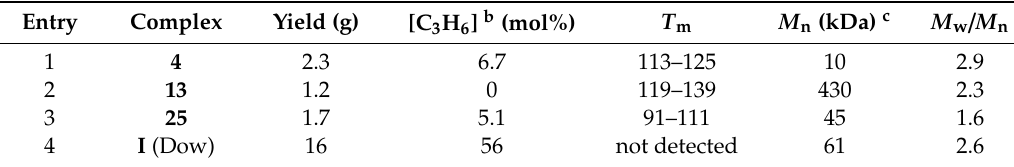
Table 1. Polymerization results a